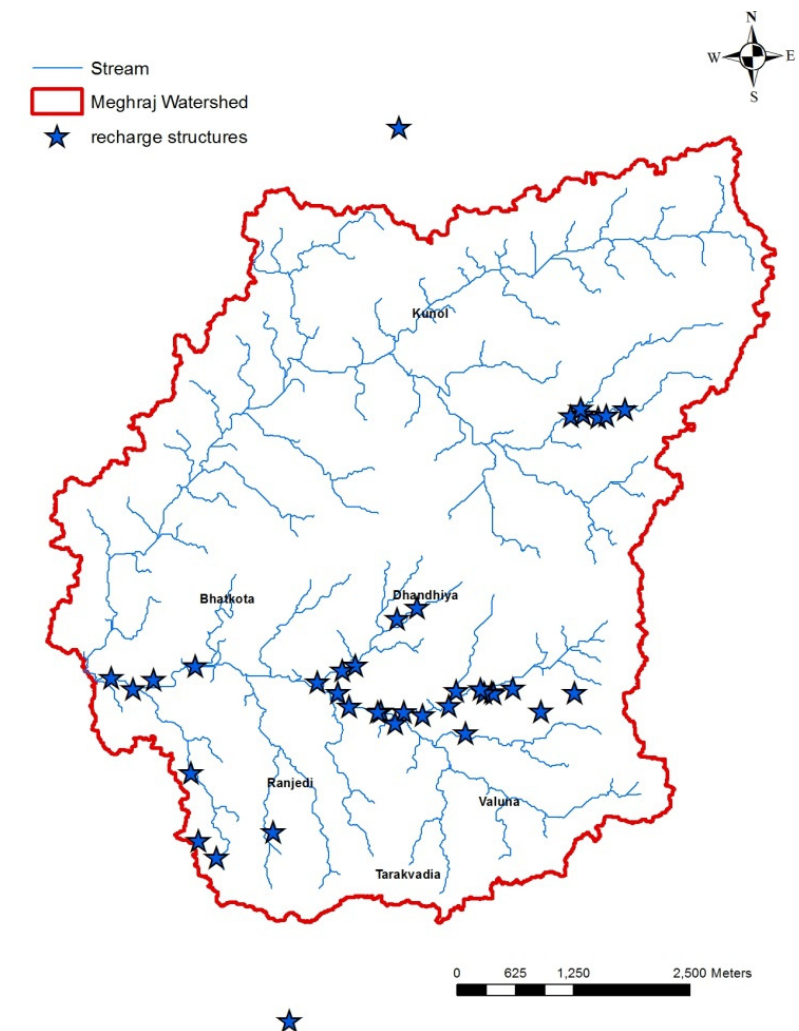
Figure 2. Location of MARs in